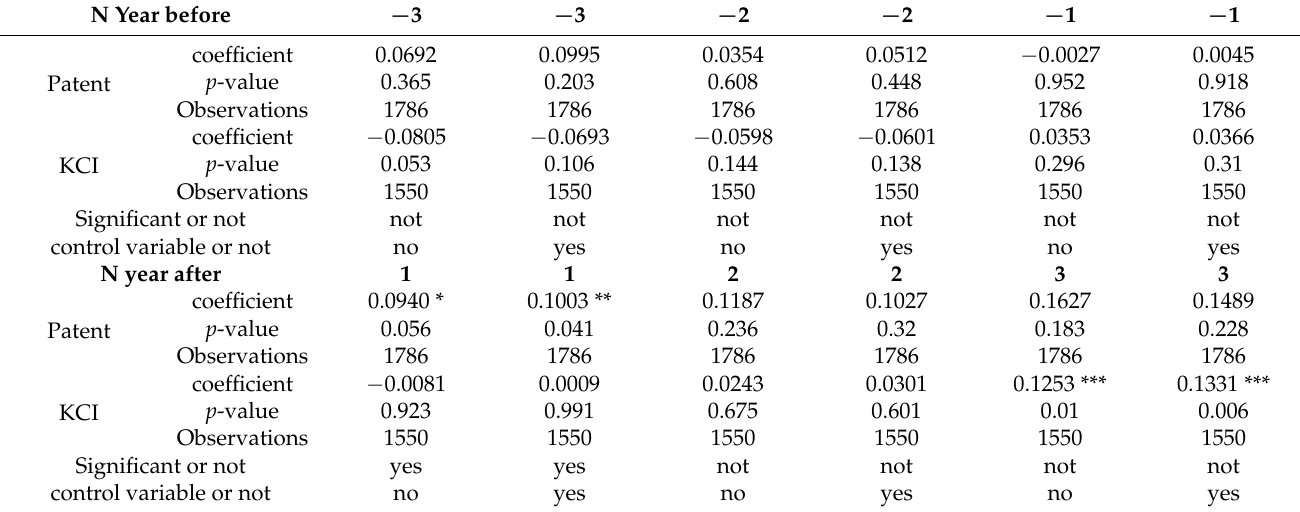
Table 4. Counterfactual test of the impact of the establishment of HIDZs on patents and